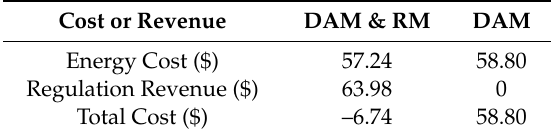
Table 2. The cost or revenue of the flow shop in electricity